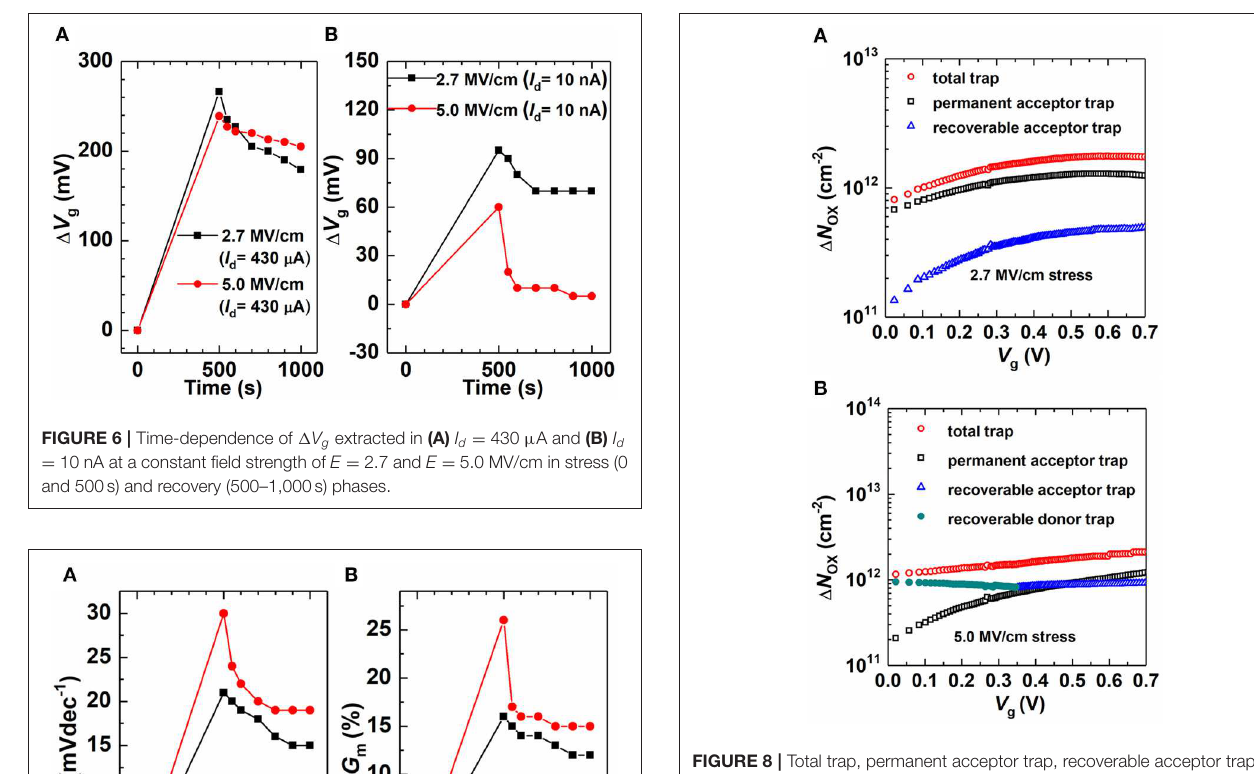
FIGURE 8 | Total trap, permanent acceptor trap, recoverable acceptor trap, and recoverable donor trap area density as a function of gate bias V g at (A) E = 2.7 and (B) E = 5.0